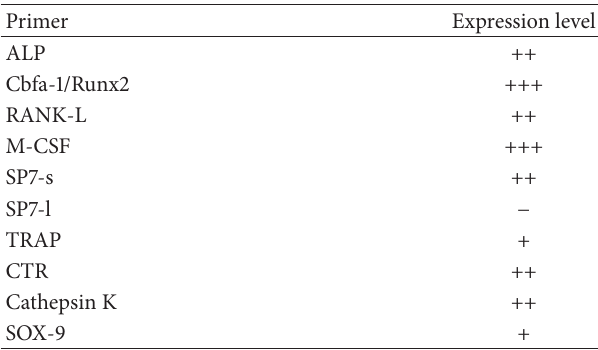
Table 2: Quantitative